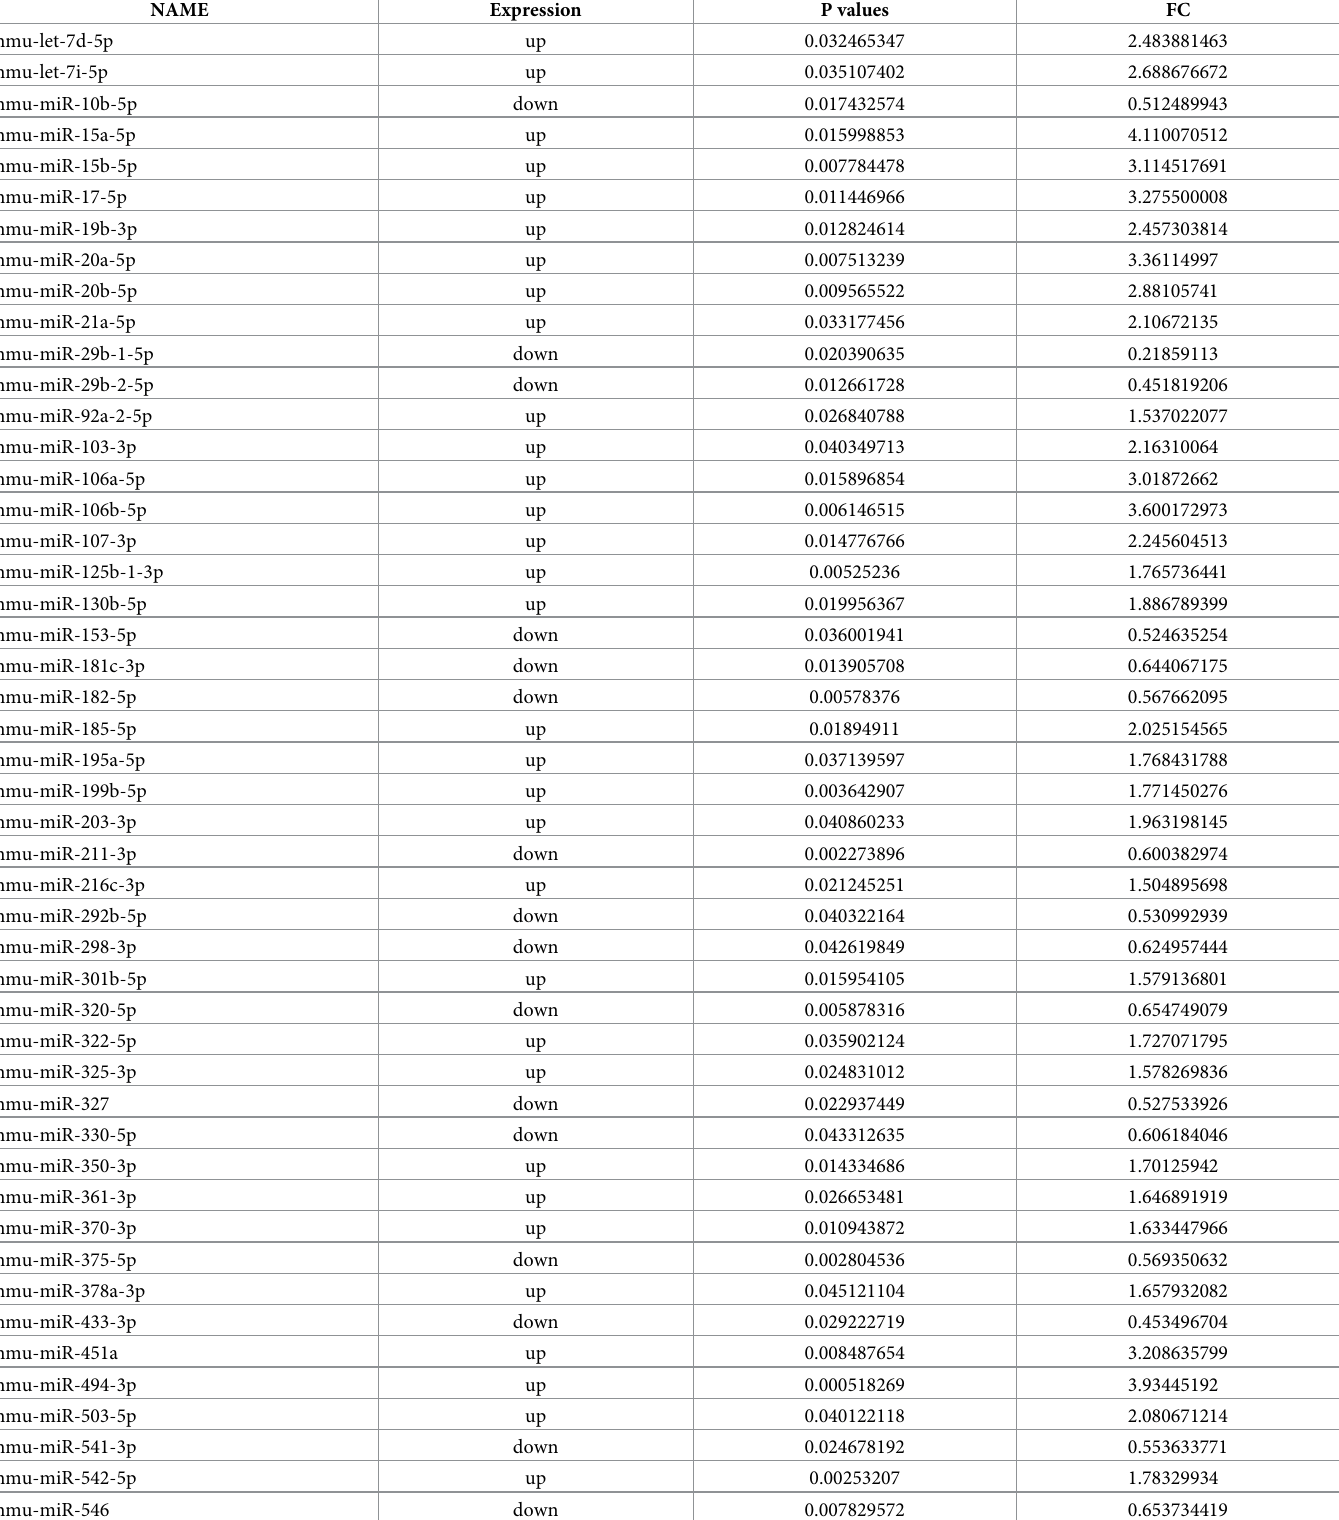
Table 2. miRNA expression profile in the serum of mice treated with